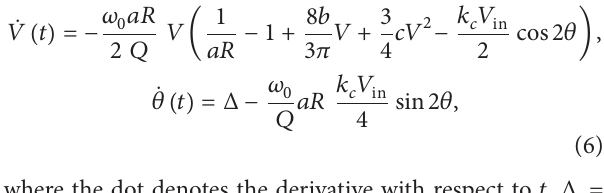
Figure 6: (a) Nonlinear characteristics of the injection circuit shown in Figure 3(b) for different values of the constant injection voltage = 𝑉 = 5 V and 𝑉 = 1 V. Measurements are obtained using integrated circuits ST HCF4007UB and the testing circuit V , obtained for 𝑉 0 in inDC DD = 0 is obtained using cubic polynomial (4) with 𝑎 in Figure 4. Approximate model for V in (b) Voltage-dependent transconductance 𝑔( V ) . Measurement’s curve is obtained using (2) and curves shown in (a). Approximate model is obtained using the last term in (4) with 𝑘 = −0.6 mA / V 2